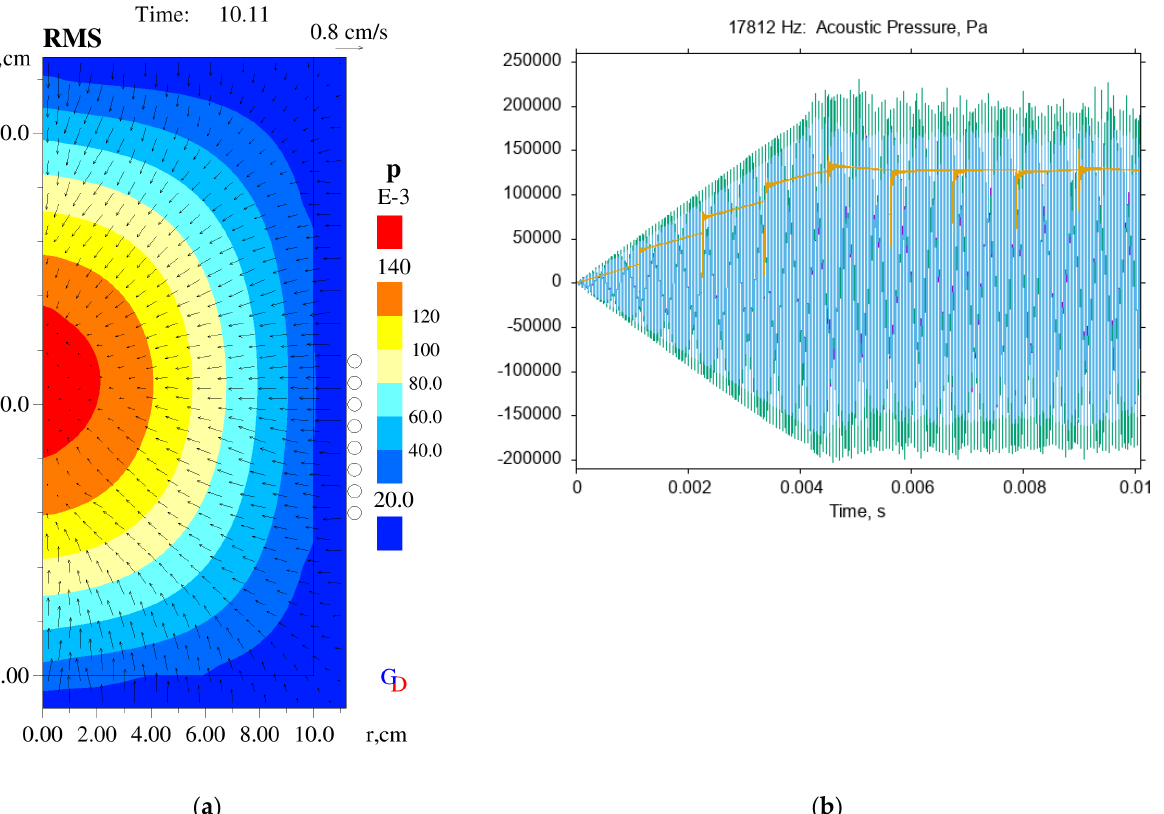
Figure 4. Simulated acoustic field: ( a ) root-mean-square (RMS) contours of acoustic pressure and instantaneous acoustic velocity vectors at the end of simulation, with time in ms; ( b ) recorded signals at monitor points (see Table 1) with nine averaging intervals for RMS.